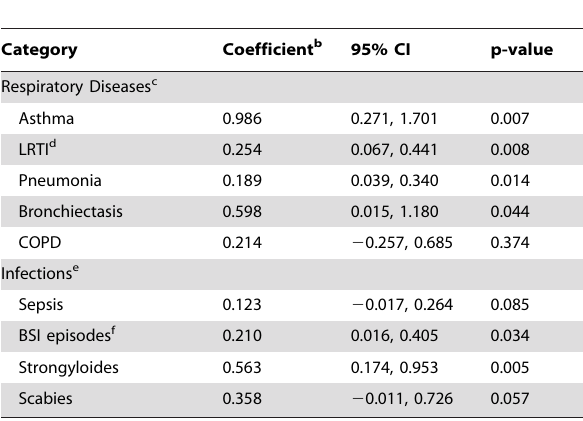
Table 5. Adjusted negative binomial regression of predictors for number of admissions a with respiratory conditions and other infections according to HTLV-1